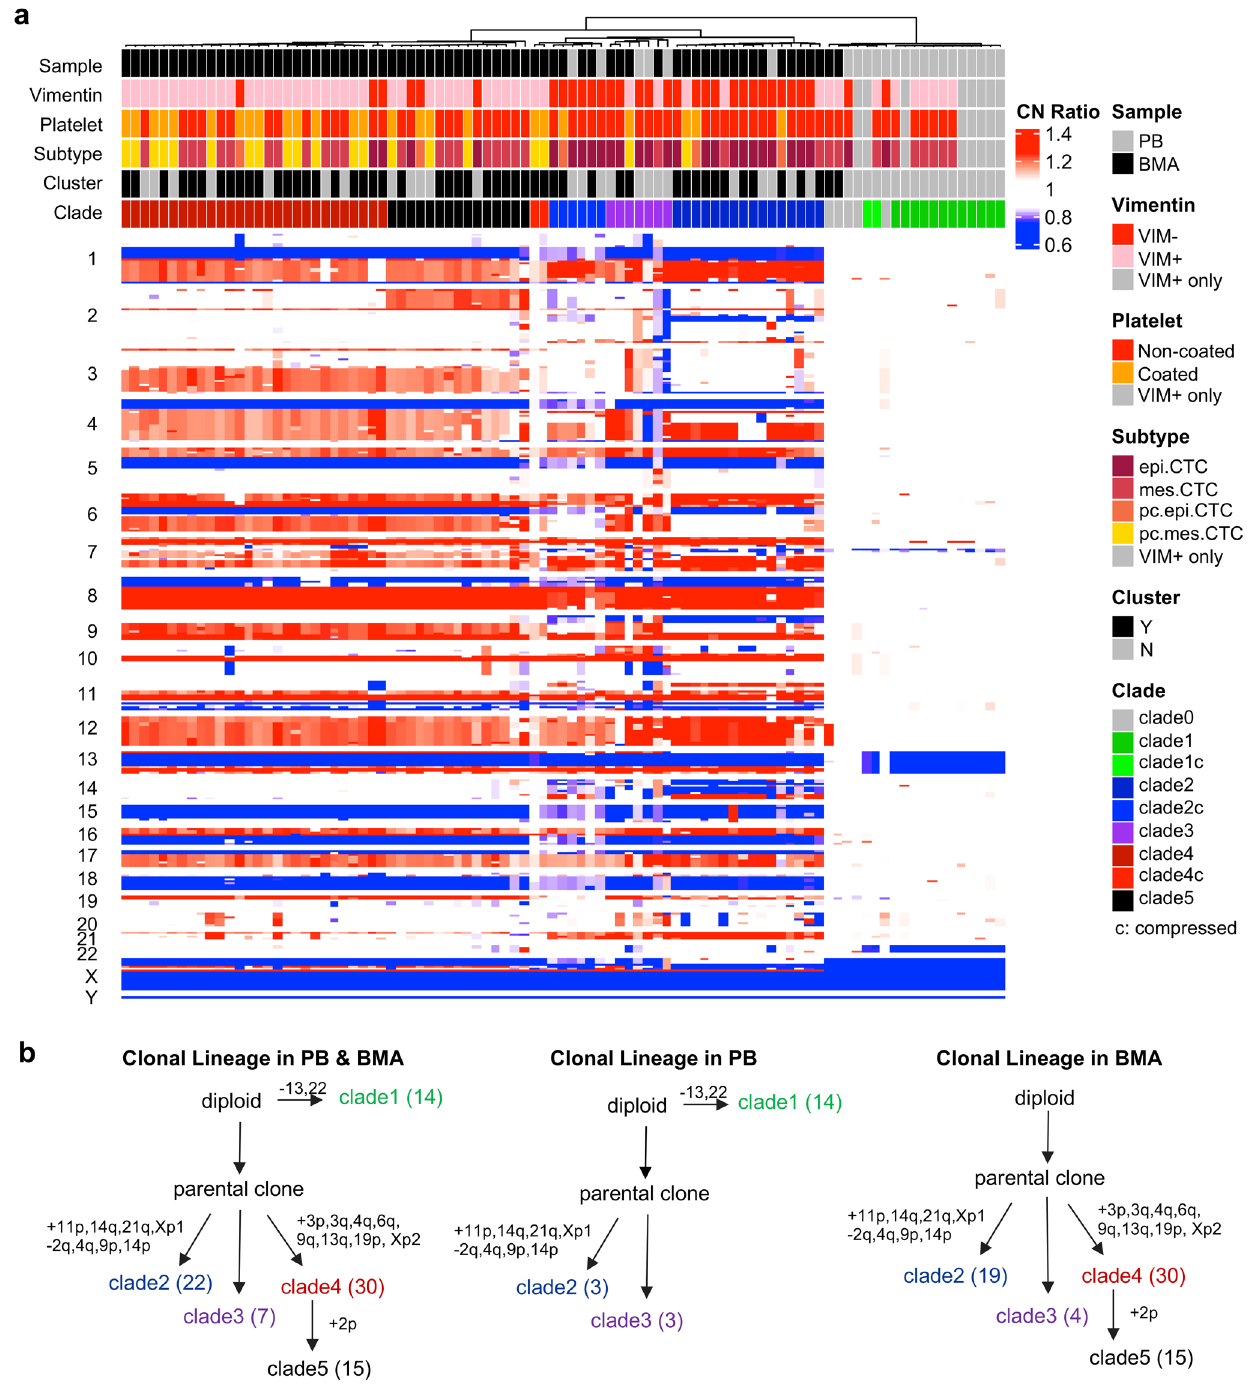
Fig. 3 Clonal lineage and its variation between PB and BMA. a Complex heatmap of single cell copy number pro fi les from paired PB and BMA grouped by hierarchical clustering. The “ c ” in clade IDs means compressed pro fi le due to normal cell contamination. Red, copy number gain; blue, copy number loss; white, copy number neutral. VIM + only refers to “ VIM + only ” rare cells. b Clonal lineage in PB and BMA combination and separate. The number in parenthesis is the number of cells clade3, and clade4/5) with the acquisition of different CNAs and multiple subclones (clade2 – 5, 74 cells) and one minor clone clade 5 was generated from clade4 with the additional chromo- (clade1, 14 cells) (Fig. 3a). Unlike common copy number pro fi ling some 2p gain (Fig. 3b left ) which was further con fi rmed by of prostate cancer cells 22 , the minor clone (clade1) had only phylogenetic tree analysis of individual cells and subclones chromosome 13 and 22 losses and its breakpoints of chromosome (Supplementary Fig. 5a – b). Intrasample comparison showed that 13 loss were different from those in the main clone (Supplemen- the subclone (clade4/5) was uniquely detected in the BMA while tary Fig. 4c). Clonal lineage tracing indicated that the parental cell the emerging minor clone (clade1) was only seen in the PB (Fig. of the main clone divided into three different subclones (clade2,